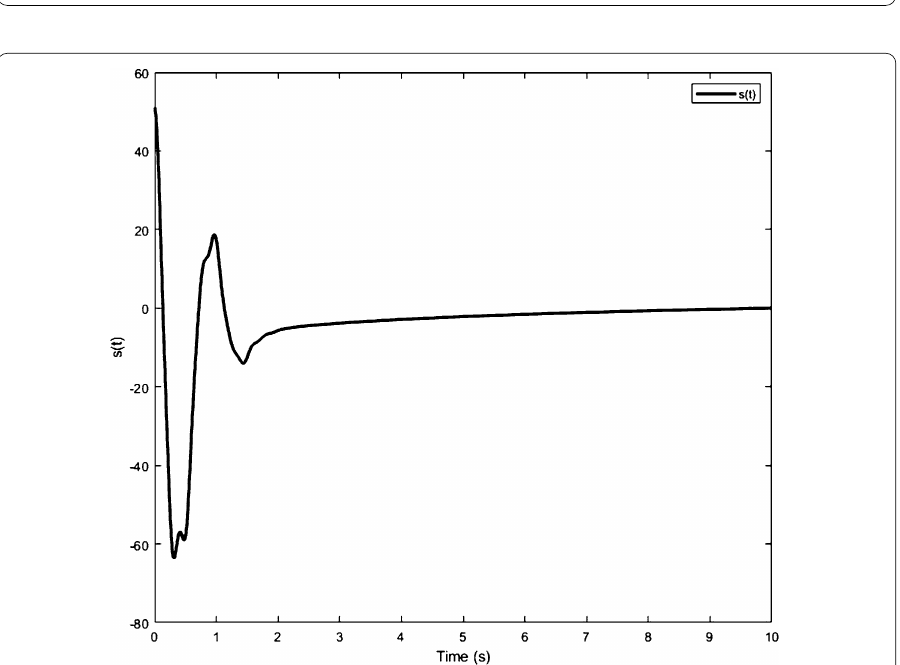
Figure 7 Time history of the sliding manifold applied for the FHPS